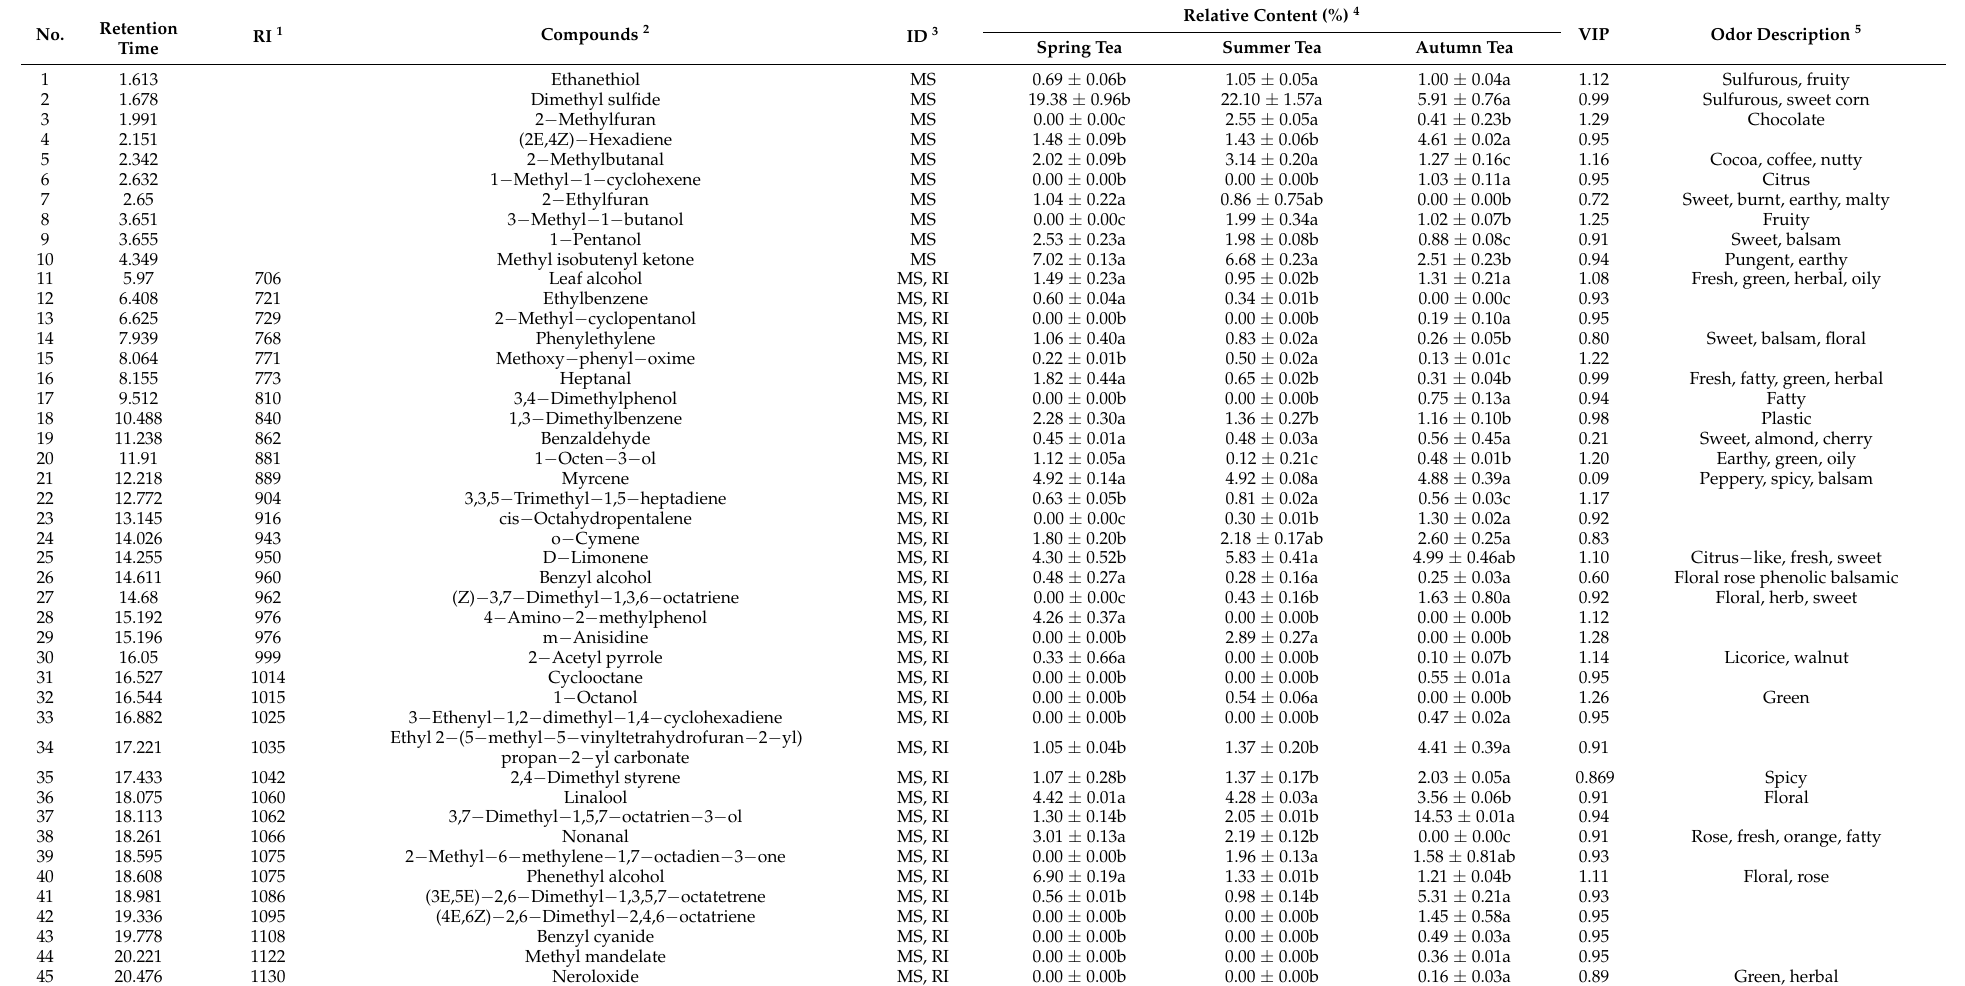
Table 2. Volatile components and their relative contents of tea in different